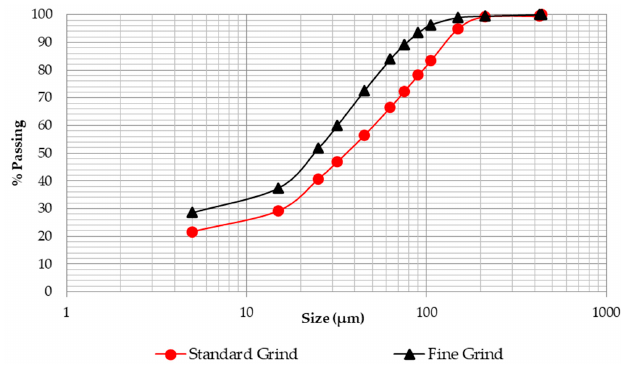
Figure 1. Particle size distribution for standard and fine grind